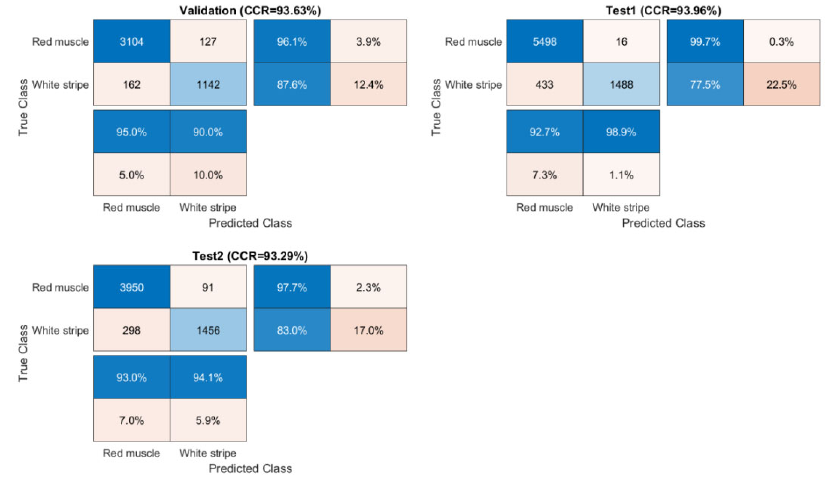
Figure 11. Confusion matrices for validation and test sets obtained by the PCA ‐ CNN model built from EPO pre ‐ treated spectra.